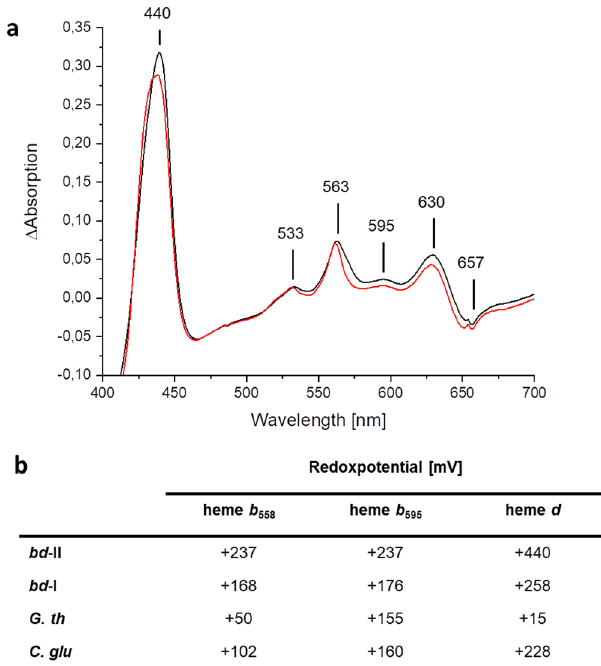
Fig. 1 Spectral and thermodynamic properties of the heme groups. a UV- vis (reduced-minus-oxidized) difference spectra of the preparation of bd -II (black) and bd -I (red). The absorbance of the individual heme groups is indicated. b Redox potential of the heme groups of various bd oxidases. The values for the oxidases other than bd -II were taken from ref. 30